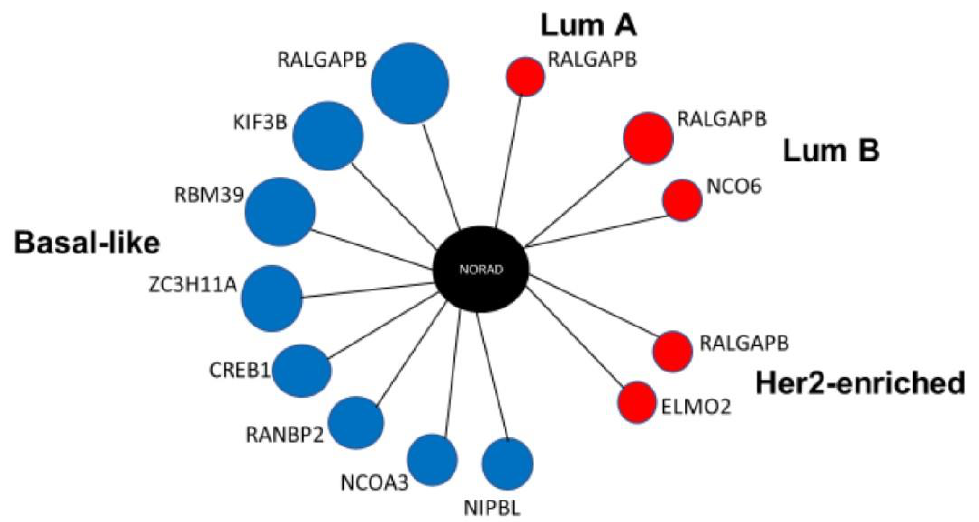
Figure 2. Co-expression network for NORAD lncRNA in BRCA subtypes. Legend: Network repre- sentation of NORAD extended in genes with higher values of mutual information in BRCA subtypes. Red circles refer to genes with high expression and blue to low expression compared to non-tumor samples in each BRCA subtype and all show a direct correlation with NORAD. The size of the dot refers to the mutual information value, whereas large dots indicate greater mutual infor- mation.